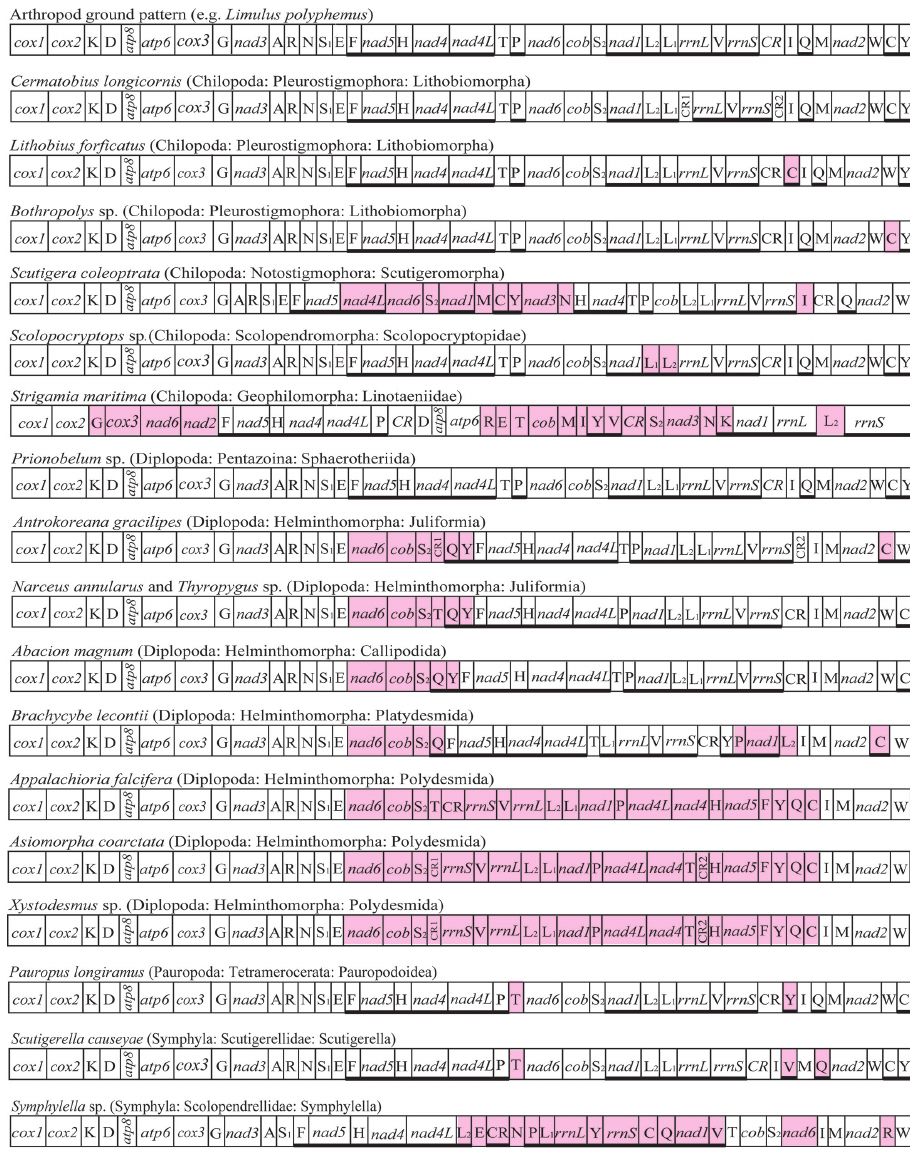
Figure 5. Comparison of gene arrangements in mtDNA of the arthropod ground pattern. Gene seg- ments are not drawn to scale. Genes shaded gray have different relative positions compared to the ground pattern. Underlining indicates the gene is encoded on the opposite strand, and arrows indicate transloca- tion of trnT . CR: putative control region. Gene arrangements of two diplopods, N. annularus and Thy- ropygus sp. are similar and represented as